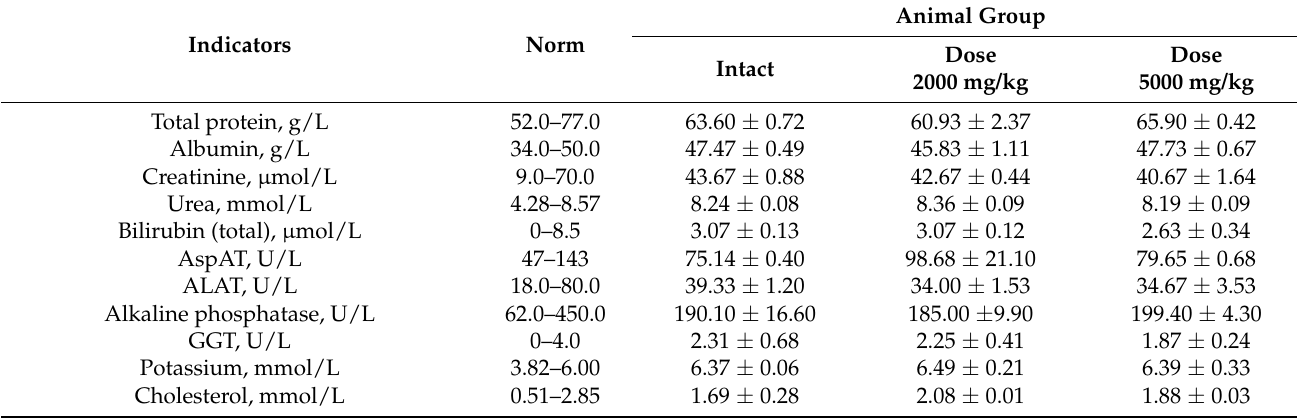
Table 5. Biochemical analysis of blood serum after acute toxicity test two weeks after the administration of D. deltoidea cell